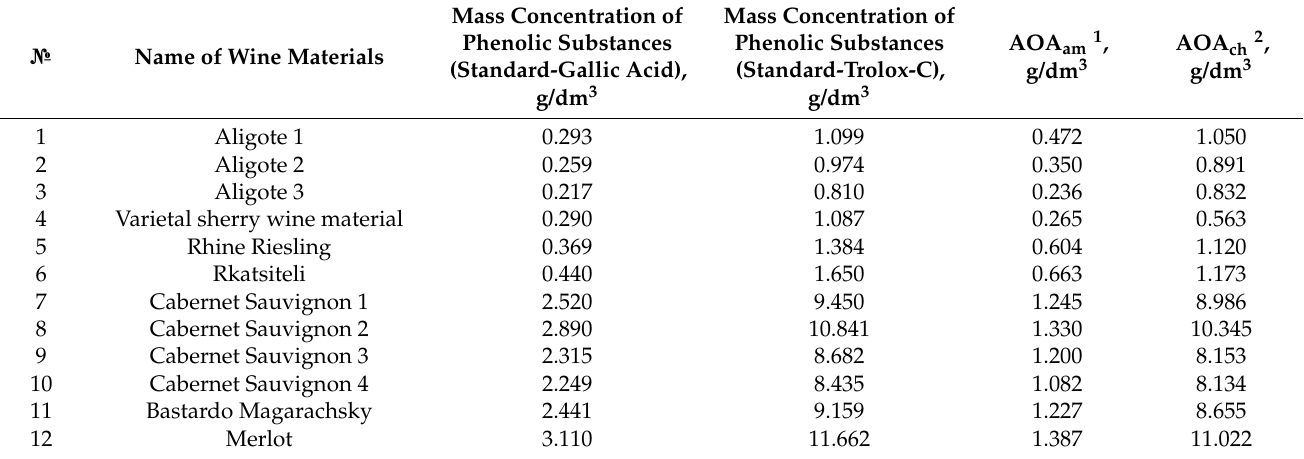
Table 2. Summary table of indicators of the mass concentration of phenolic substances and antioxidant